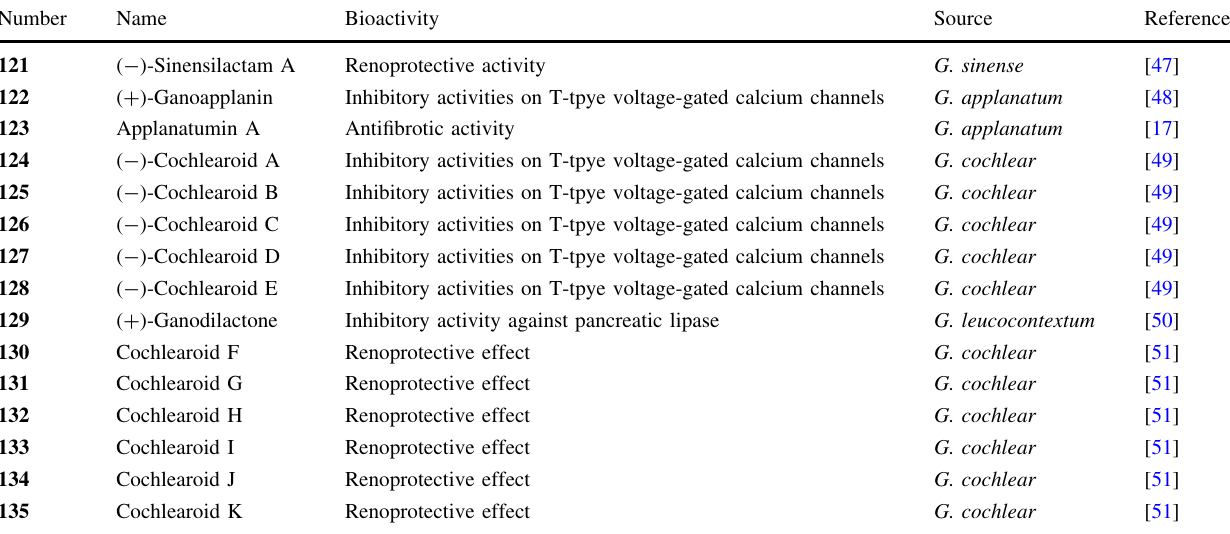
Fig. 8 Structures of dimeric GMs Table 3 Name, source and bioactivities of dimeric